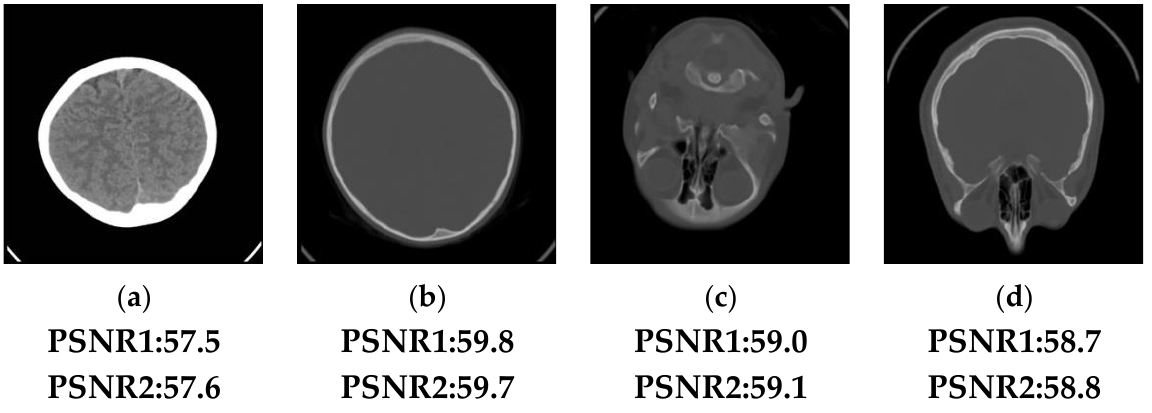
Figure 15. Application example of the proposed method on medical images and their different PSNR values: ( a ) Brain, ( b ) Bone 1, ( c ) Bone 2, and ( d ) Bone 3.